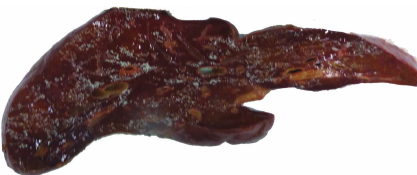
Figure 1: Gross photograph of the native liver. The specimen weighs 645 g and measures 23 × 15 × 4cm. Cross section through greatest dimension of the liver shows a shrunken and hemorrhagic liver indicative of parenchymal